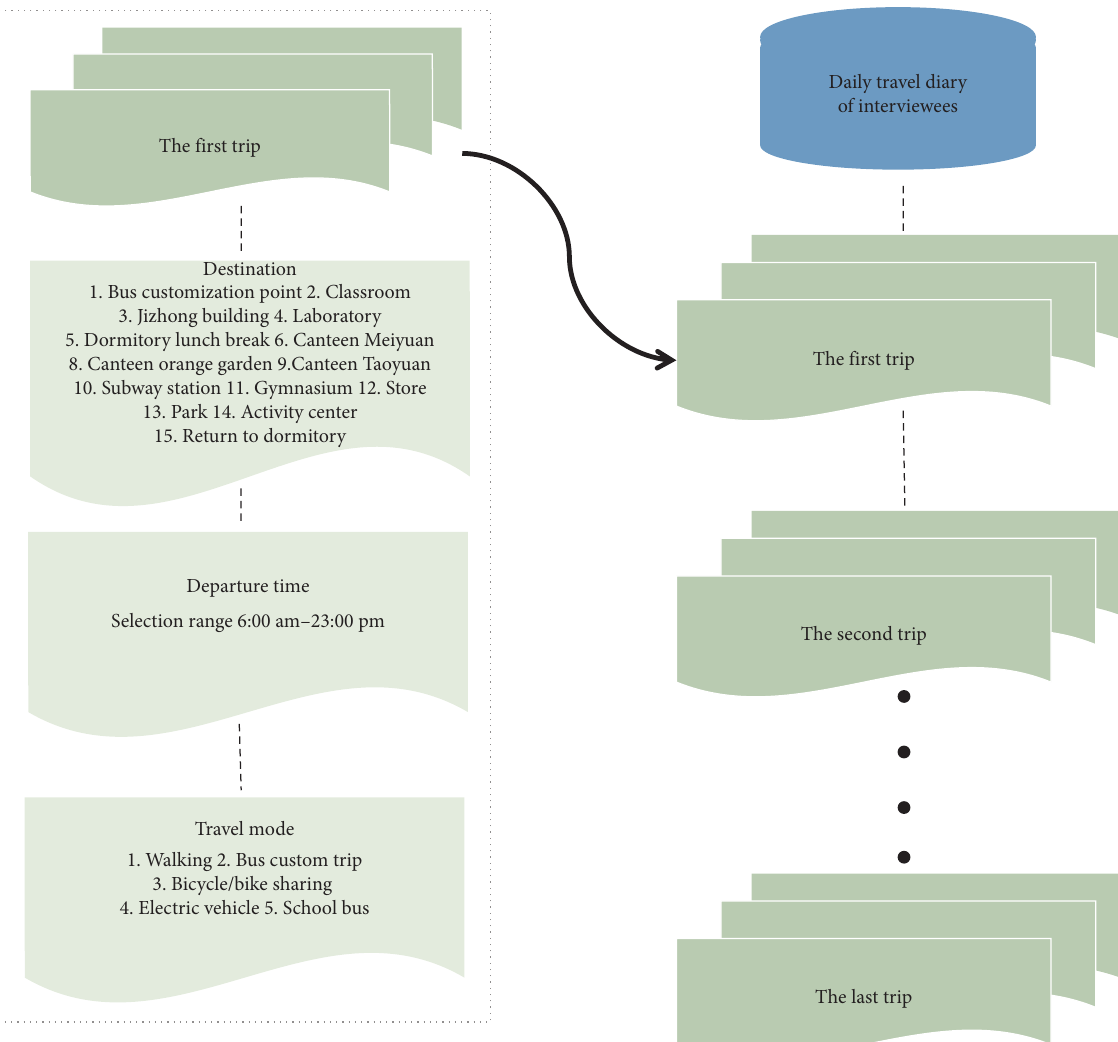
Figure 5: Structure of travel diary survey in the SP